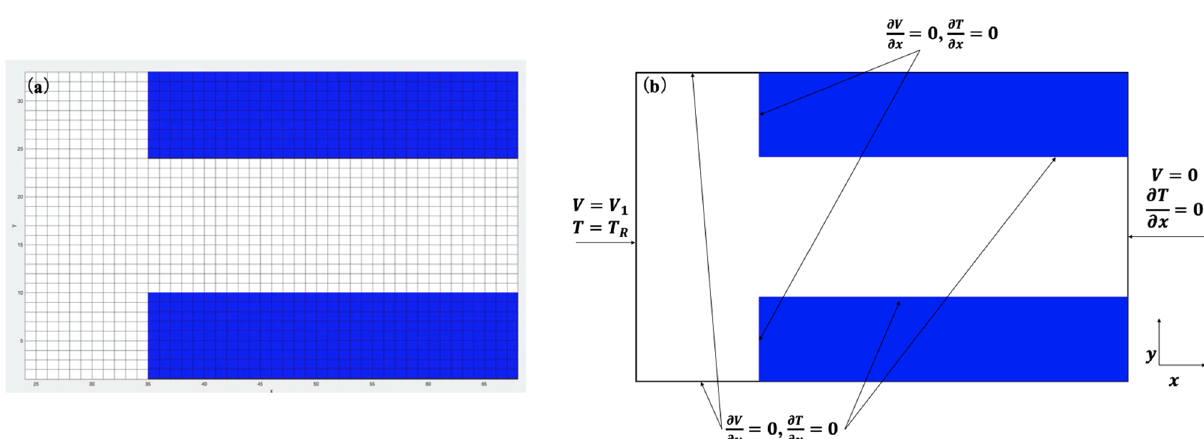
Figure 6. Model of simulation ( a ) cells of the strip ( b ) boundary conditions for the